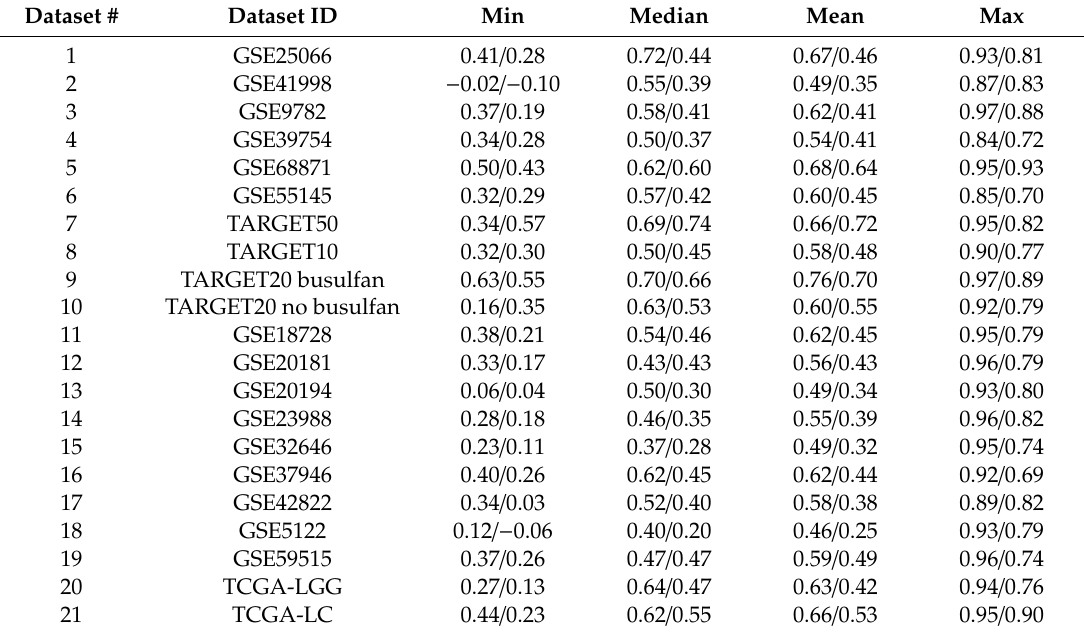
Table 5. Minimal, median, mean and maximal Pearson / Spearman correlation values for pairwise comparison of di ff erent ML methods with FloWPS at the level of feature importance ( I f